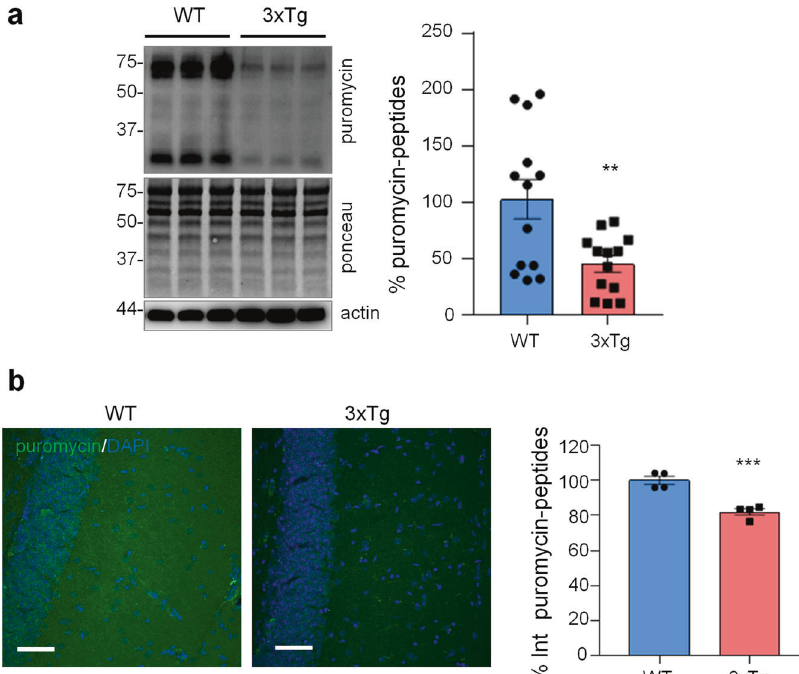
Fig. 5 Protein synthesis analysis in WT and 3xTg-AD mice. WT and 3xTg-AD mice were i.p. injected with 225 mg/Kg of puromycin and sacri fi ced 1.5 h post-injection. a WB with anti-puromycin, anti-actin antibodies, and ponceau staining on hippocampal homogenates. Data are expressed as mean ± SEM of 13 independent WB from two mice per genotype. ** p < 0.01, unpaired t -test. b IF with anti-puromycin antibody (green) and DAPI (blue) of hippocampal brain slices. Data are expressed as mean ± SEM of four sections collected from two mice per genotype. Scale bar = 50 μ